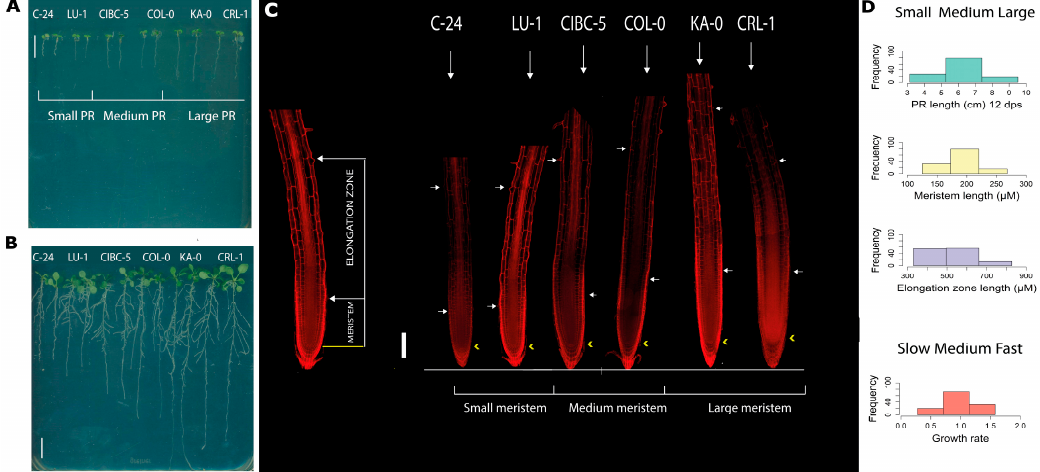
Figure 1. Representative accessions (two seedlings per accession) with short, medium and large PR at 5 dps ( A ) and 12 dps ( B ). ( C ) Median longitudinal confocal images of PR roots at 5 dps observed in ( A ); the meristem and the elongation zones are shown. The yellow arrow marks the QC and the initiation of the meristem and the white arrows indicate the end of the meristem and the initiation of the EZ that ends with the first epidermal cell with a bulge hair root. Roots were stained with propidium iodide. The six accessions: C-24, LU-1, CIBC-5, COL-0, KA-0 and CRLl-1 have the same classification regarding their PR and meristem length. ( D ) For each of the 124 accessions ( n = 10 seedlings used per accession), we plotted the frequency of small, medium and large regarding primary root length and root growth rate at 11 and 12 dps and the meristem and elongation zone length of 5 dps roots using Sturge’s rule to see the distribution of the values. In ( A , B ) scale bar = 1 cm, in ( C ) the bar represents 100 µ